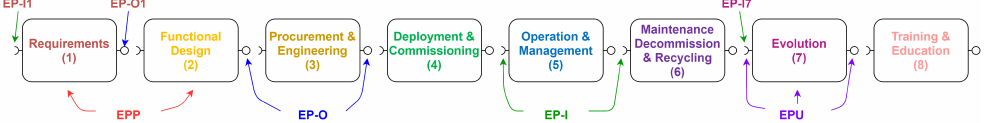
Figure 3. The Arrowhead Engineering Process and Engineering Process Units defined in the